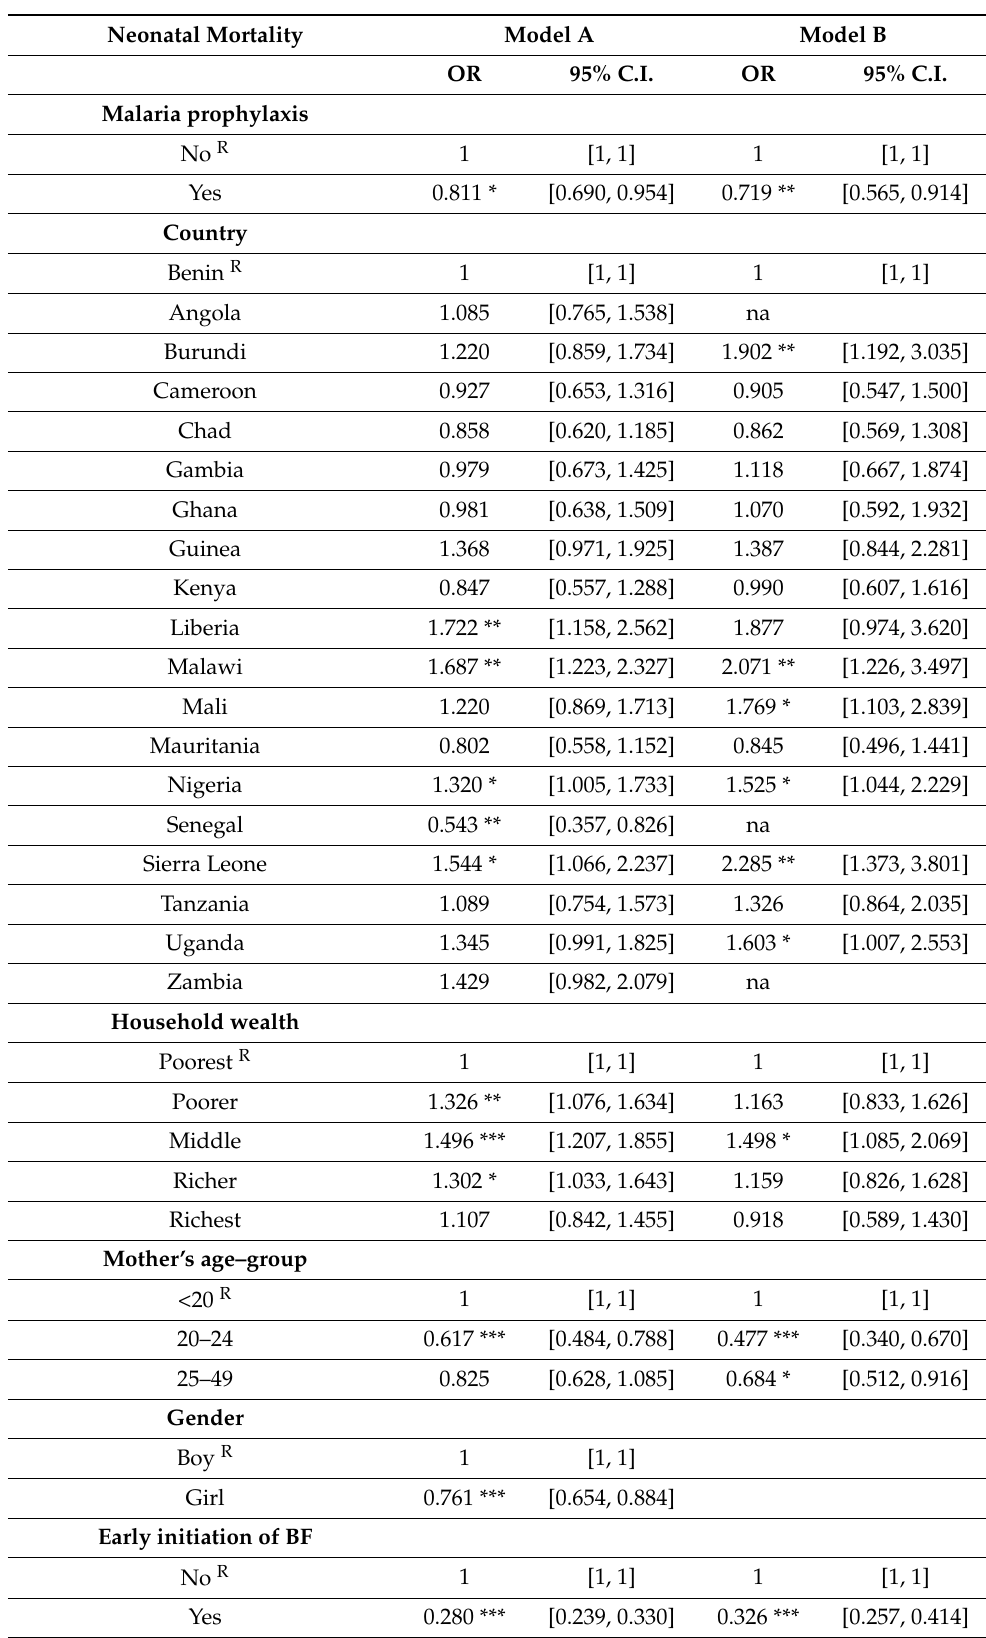
Table 8. Multivariate logistic regression model on neonatal